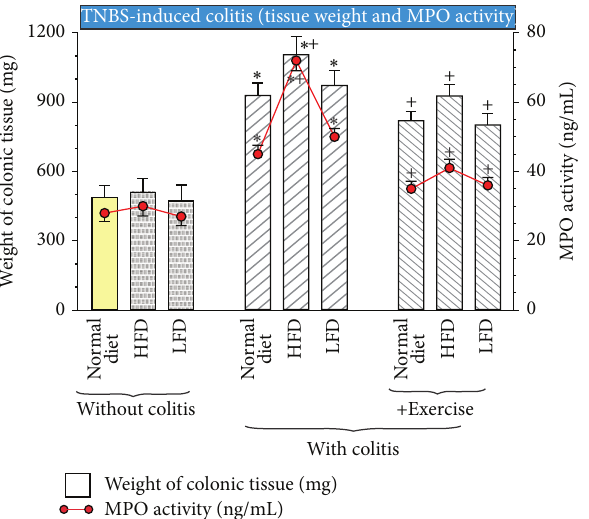
Figure 4: The effect of exercise on the weight of colonic tissue and the colonic MPO levels in rats with or without TNBS colitis fed normal diet, HFD, and LFD. Results are mean ± SEM of seven ani- mals per each group. An asterisk indicates a significant difference ( 𝑃 < 0.05 ) as compared with the control groups of animals (without colitis). An asterisk and cross indicate a significant difference ( 𝑃 < 0.05 ) as compared to the values obtained in rats fed normal diet. Cross indicates significant difference ( 𝑃 < 0.05 ) as compared to the values obtained in TNBS rats fed different diets without exercise.